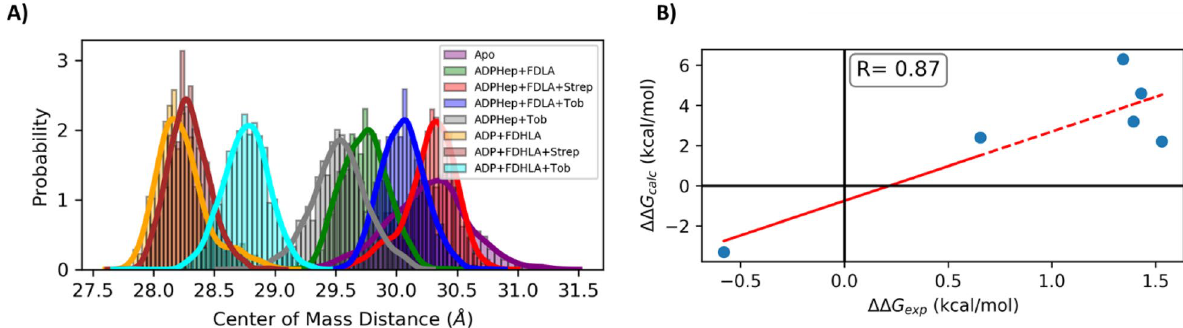
Figure 8. ( A ) Probability distribution of center of mass distance between N and C termini of HepI in the apo (purple), substrate (green), substrates with Streptomycin (red), substrates with Tobramycin (blue), HepI binary with Tobramycin (grey), products (orange), products with Streptomycin (brown), and products with Tobramycin (cyan). ( B ) Binding free energy differences of Tobramycin/Streptomycin to HepI WT relative to ARG/LYS mutants.